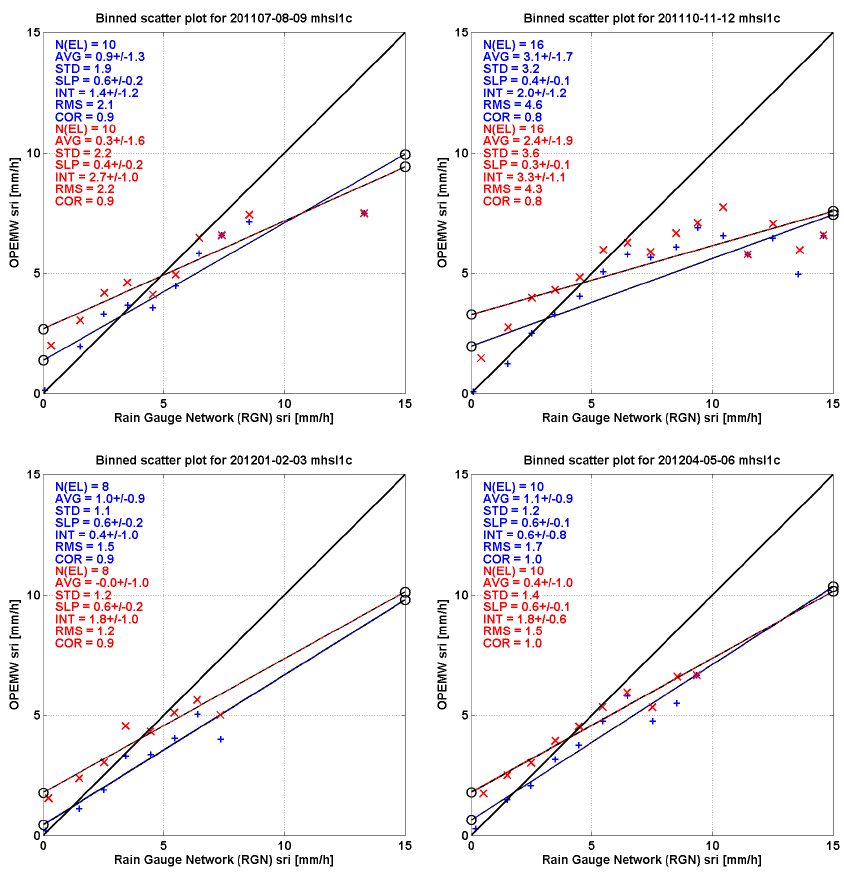
Figure 8: Scatter plot of seasonal binned analysis with respect to RGN; clockwise from top-left 3 Fig. 8. Scatter plot of seasonal binned analysis with respect to RGN. Clockwise from top-left panel: summer (July-August-September 2011), fall (October-November-December 2011), winter (January-February-March 2012), and spring (April-May-June 2012). Markers and statistics panel: Summer (July-August-September 2011), Fall (October-November-December 2011), Winter 4 are as in Fig. 7. Error bars have been omitted to improve figure (January-February-March 2012), and Spring (April-May-June 2012). Markers and statistics are as 5 in Fig. 7. Error bars have been omitted for improving figure readability. 6